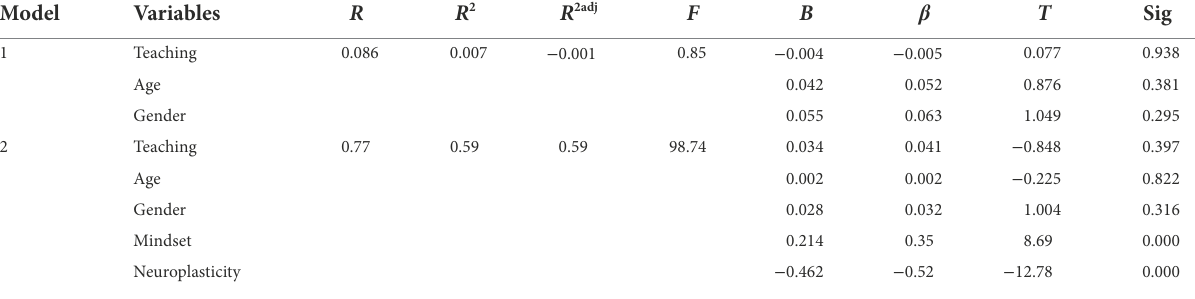
TABLE 3 The regression analysis of the background and main